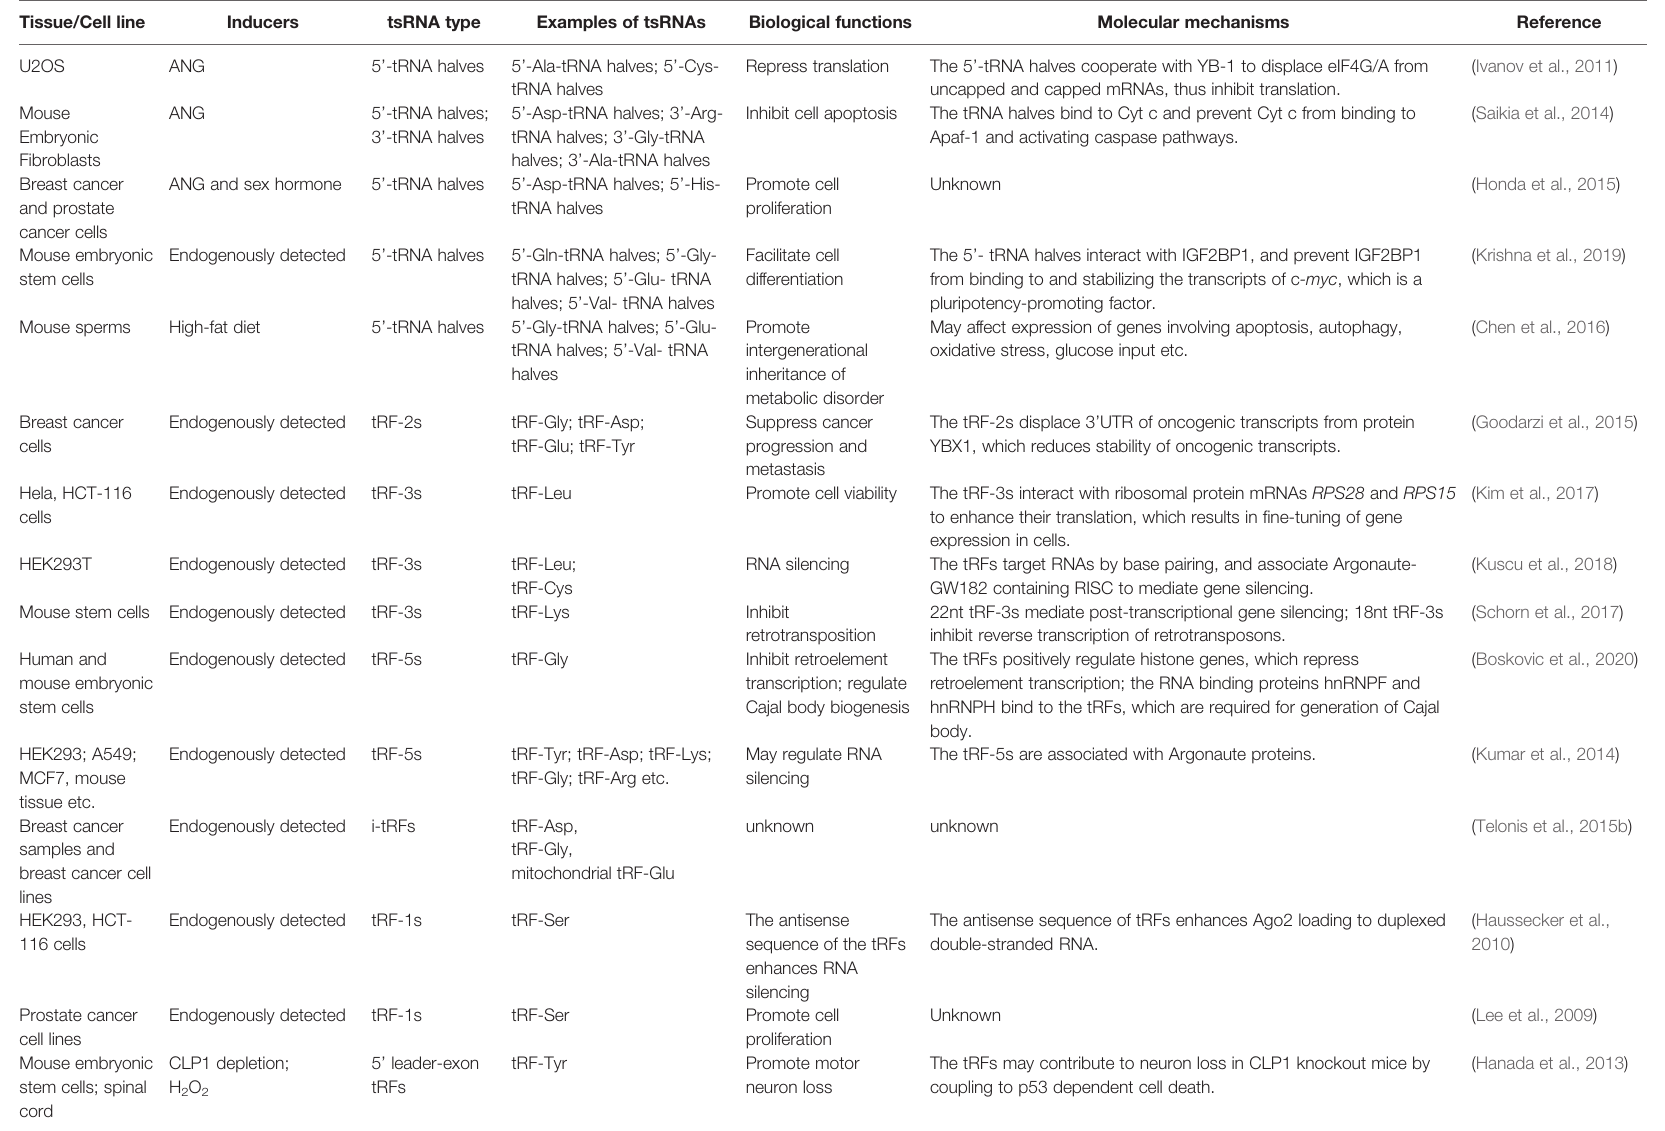
TABLE 1 | Summary of transfer RNA-derived small RNAs (tsRNAs) and their biological